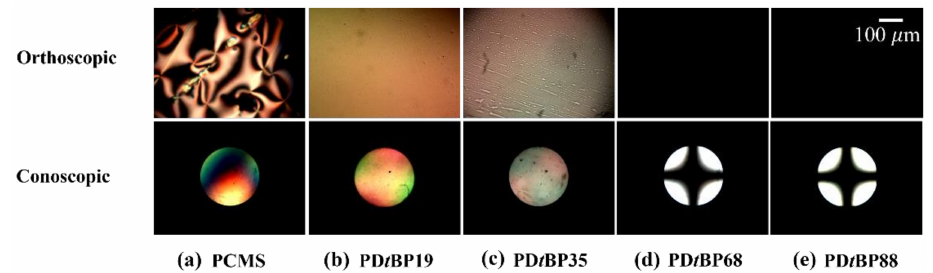
Figure 6. Orthoscopic and conoscopic POM images of the LC cells made from: ( a ) PCMS, ( b ) PD t BP19, ( c ) PD t BP35, ( d ) PD t BP68, and ( e ) PD t BP88